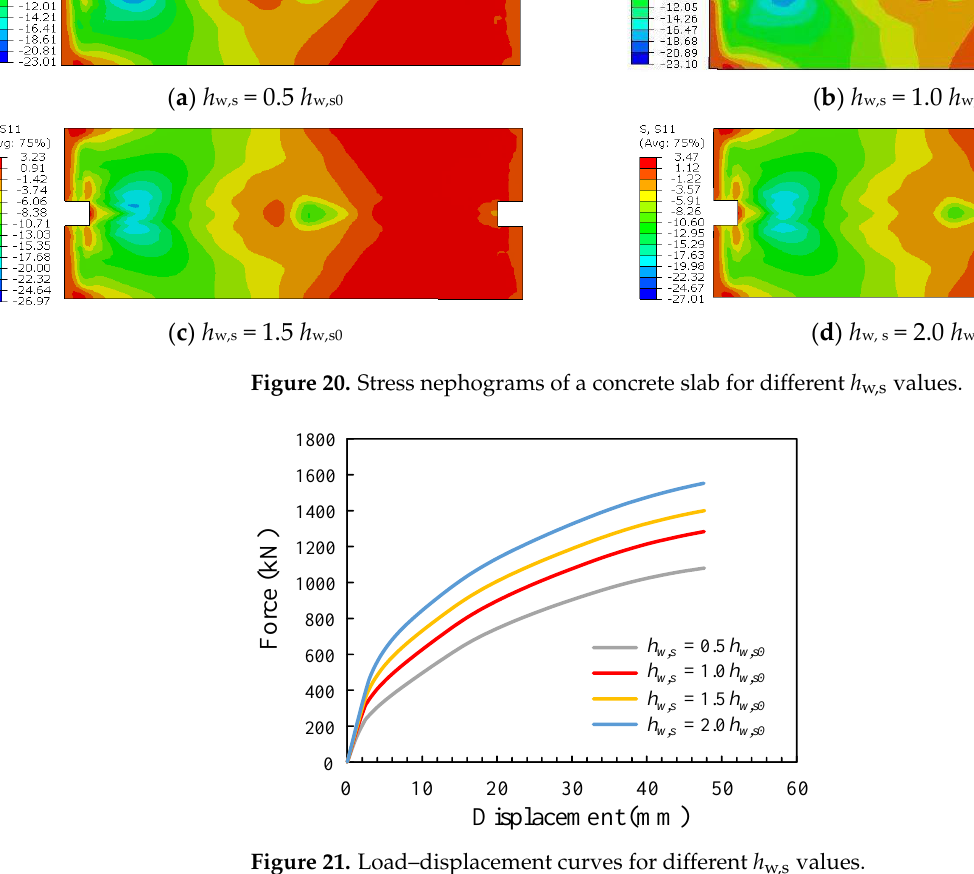
Figure 20. Stress nephograms of a concrete slab for different h w,s values.